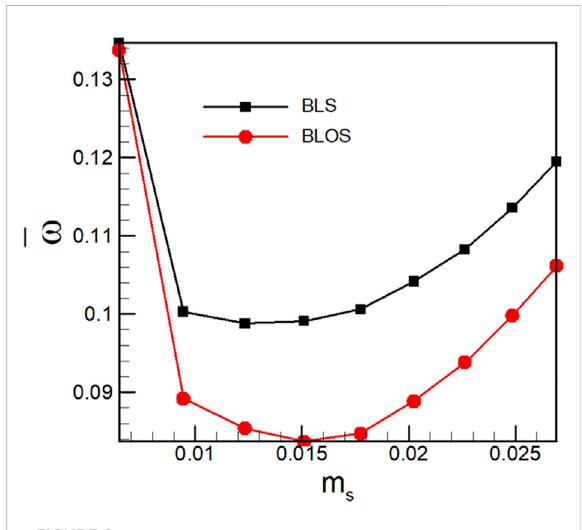
FIGURE 9 Distribution of time-averaged total pressure loss by thetime- averaged suction mass fl ow in the control of BLOS and